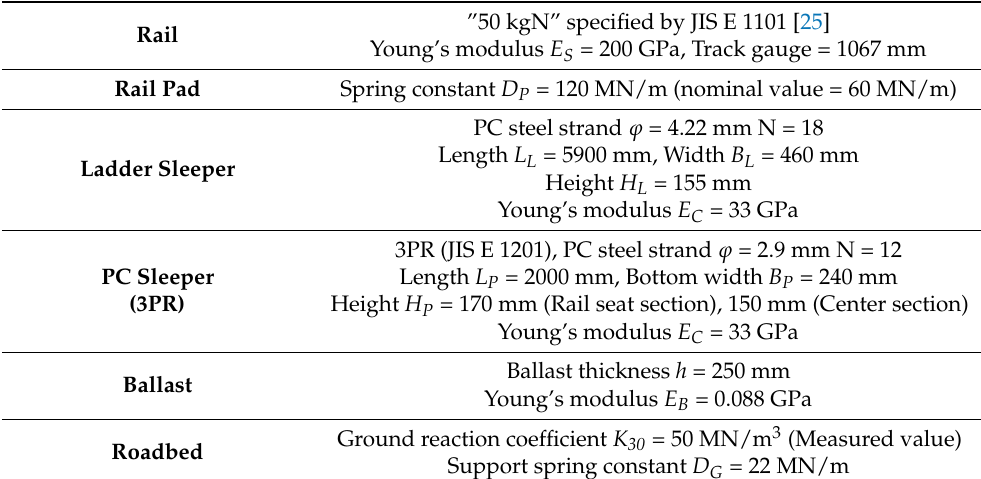
Table 1. Material constants used in the numerical